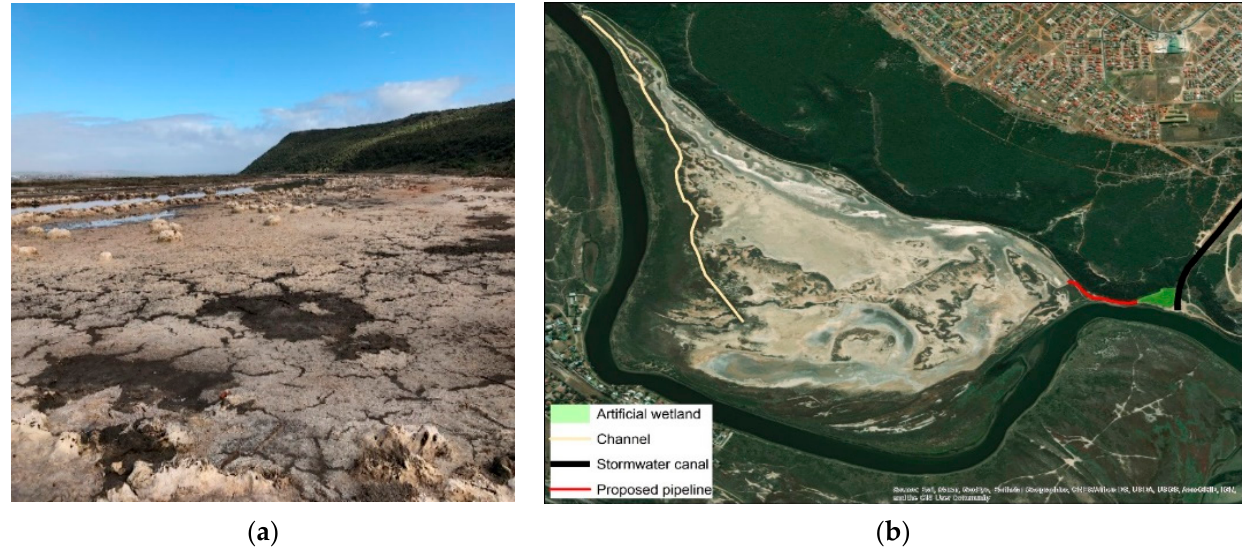
Figure 5. Restoration of salt marsh at an abandoned salt pan, Swartkops Estuary, South Africa, showing ( a ) the bare salinized pan and ( b ) the proposed location of a pipe that is intended to deliver stormwater from the Motherwell canal. Map source: Esri, Maxar, GeoEye, Earthstar Geographics, CNES/Airbus DS, USDA, USGS, AeroGRID, IGN and the GIS User Community.